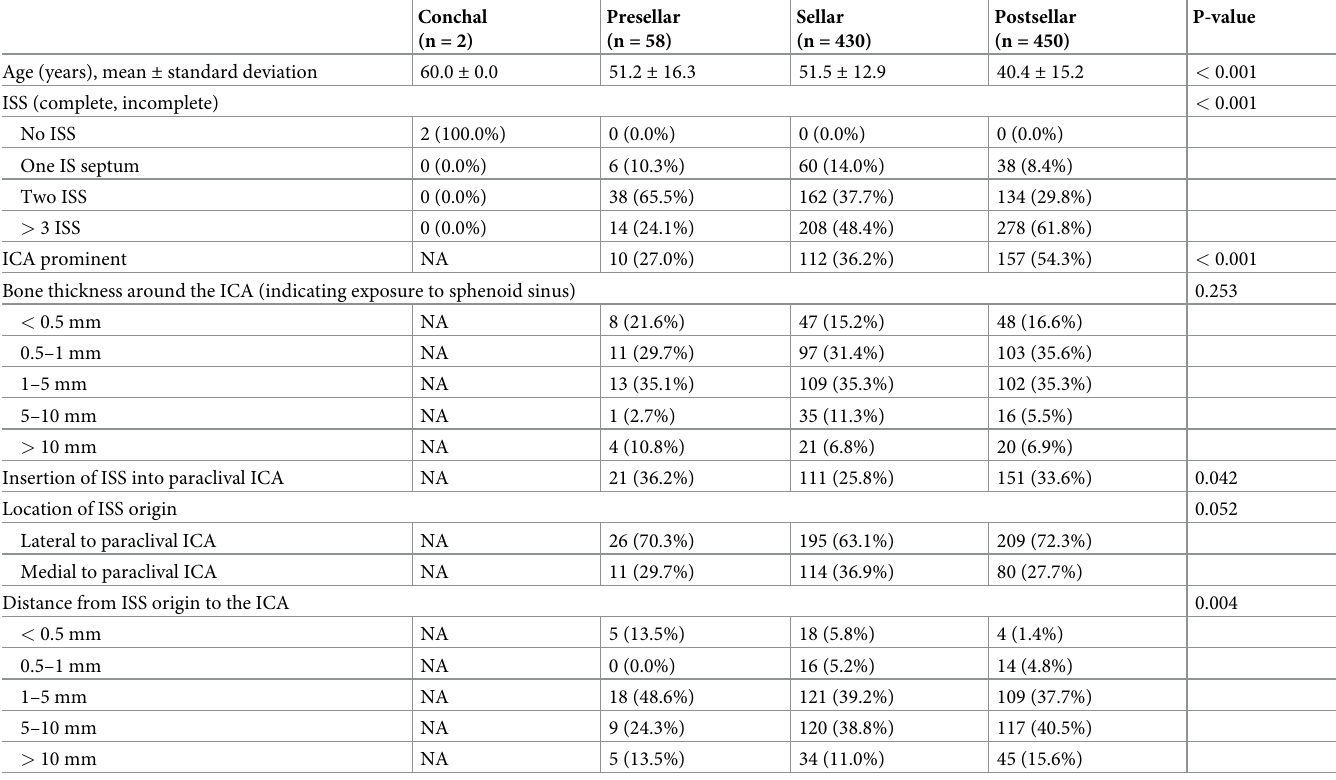
Table 1. Relationships of sphenoid sinus pneumatization type with ISS and ICA features, as revealed by preoperative axial paranasal computed tomography �